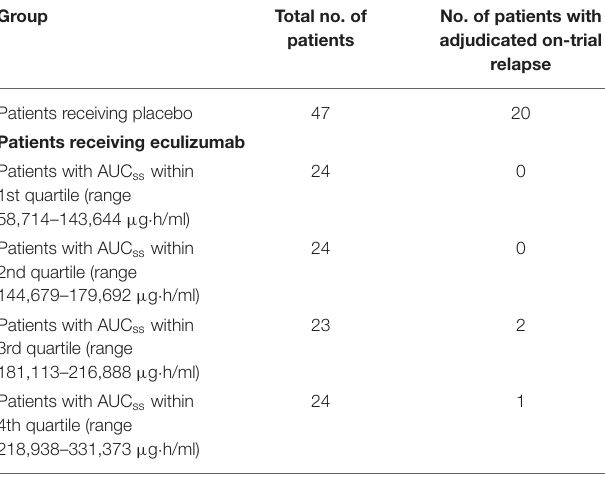
FIGURE 4 | Eculizumab exposure–response profiles for serum free C5 concentration and hemolytic activity. Scatterplots of (A) time-matched serum free C5 concentrations and eculizumab concentrations, and (B) time-matched percent hemolysis and eculizumab concentrations. Vertical lines at eculizumab 116 µ g/ml and horizontal lines at free C5 0.5 µ g/ml in panel A and 20% hemolysis in panel B show thresholds representing complete terminal complement inhibition for serum eculizumab concentration, and for free C5 concentration and hemolytic activity, respectively. C5, complement component